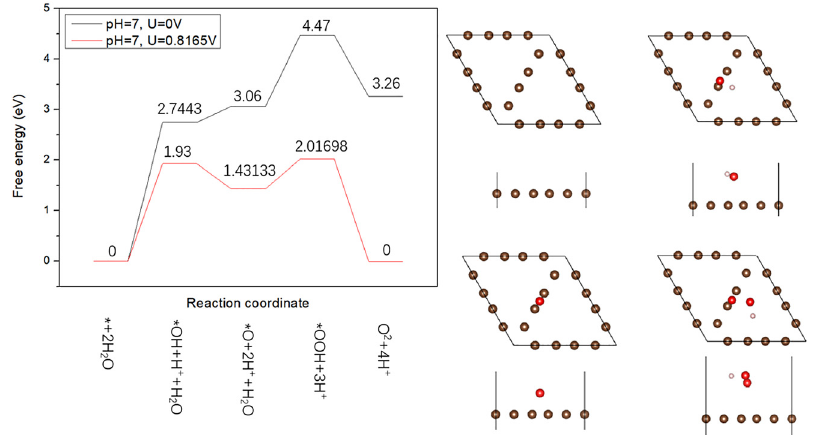
Figure 2: Free energy of four steps of oxygen evolution reaction (OER) reaction on the graphdiyne as the